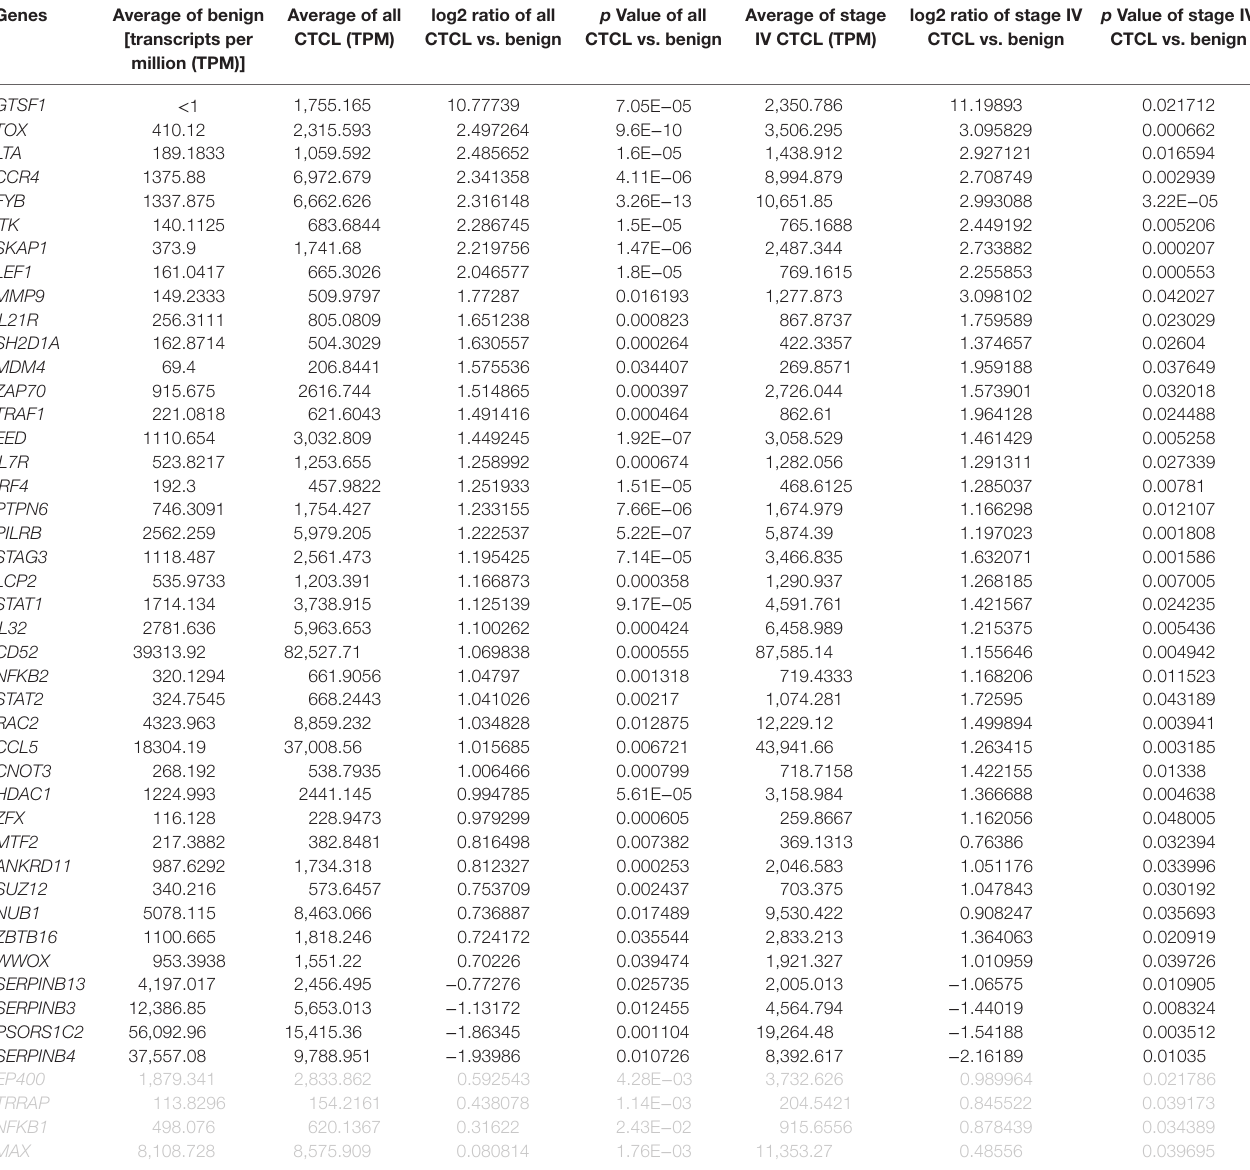
average of all log2 ratio of all cTcl (TPM) cTcl vs. benign